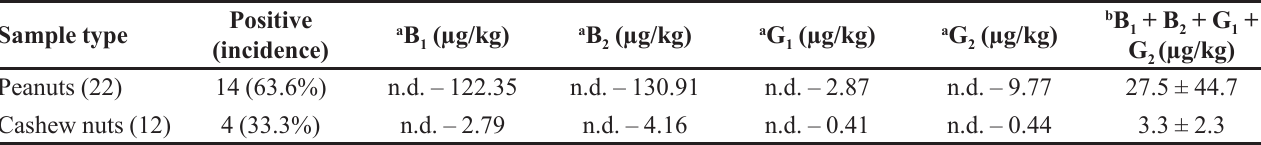
TABLE II - Levels of AFB (Natal, RN, Brazil) monitored by HPLC-FD analysis